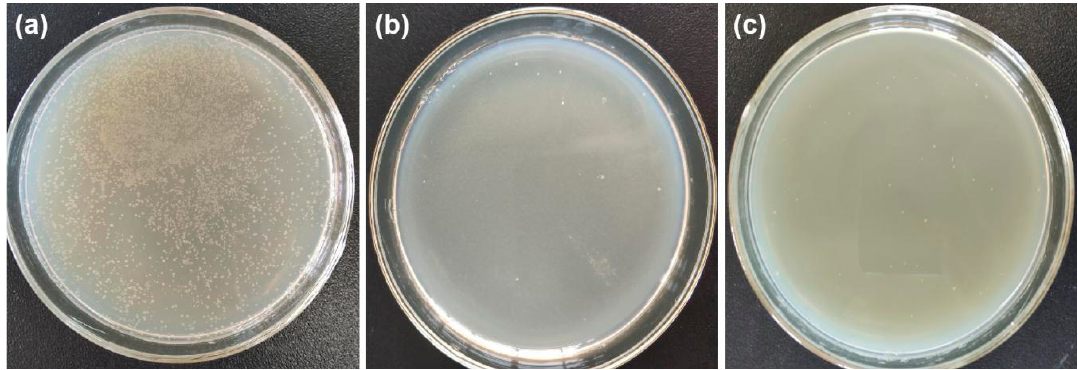
Figure 11. Antibacterial activities of ( a ) PET fabrics; ( b ) Cu/Ag/PDA/PET fabrics; and ( c ) after washing for 10 cycles.